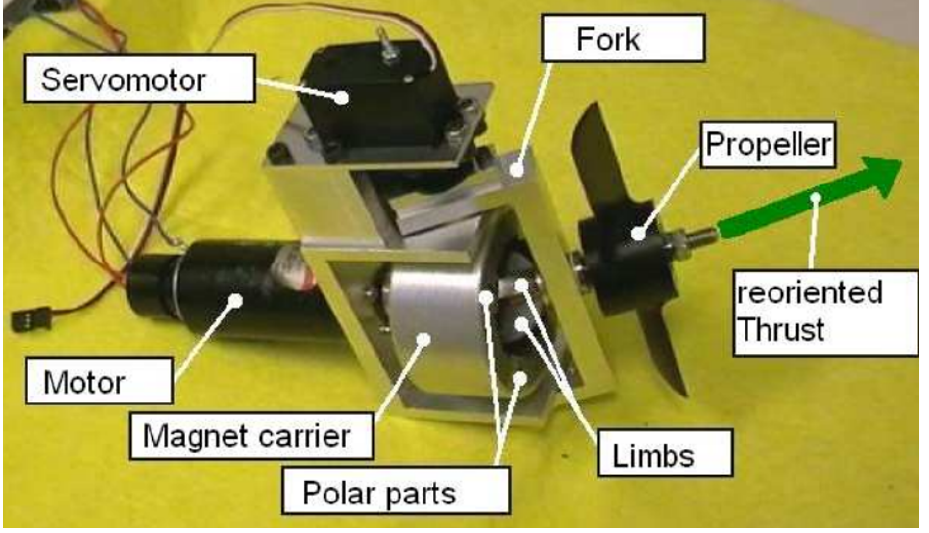
Figure 12. Spherical-RMCT prototype [5].